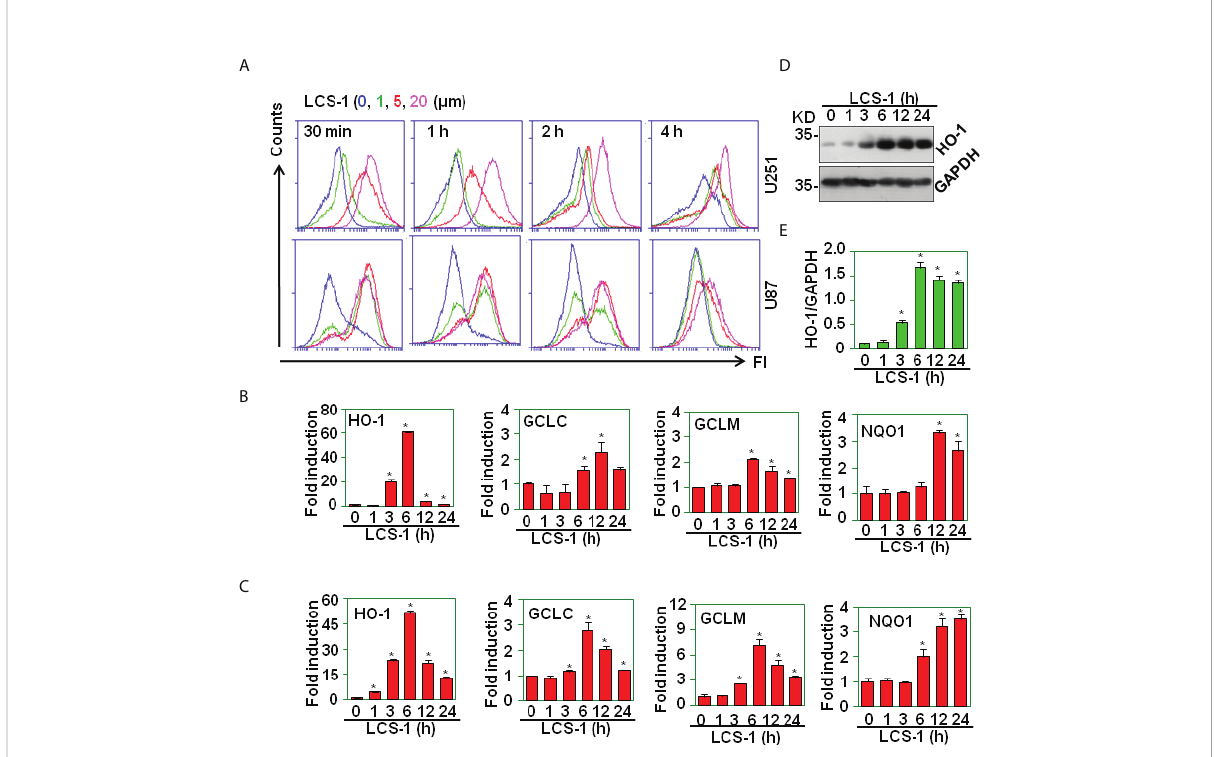
FIGURE 3 LCS-1 induces the production of ROS. (A) DCF staining analysis of ROS levels in U251 and U87 cells treated with the indicated doses of LCS-1 for the indicated time periods. (B) qRT-PCR analysis of the mRNA levels of NRF2-targeted genes in U251 cells treated with 10 µM LCS-1 for the indicated time periods. * P < 0.05 compared with the control groups. (C) qRT-PCR analysis of the mRNA levels of NRF2-targeted genes in U87 cells treated with 10 µM LCS-1 for the indicated time periods. * P < 0.05 compared with the control groups. (D) Western blot analysis of the protein levels of HO-1 in U87 cells treated with 10 m M LCS-1 for the indicated time periods. (E) Quantitative data from (D) * P < 0.05 compared with the medium